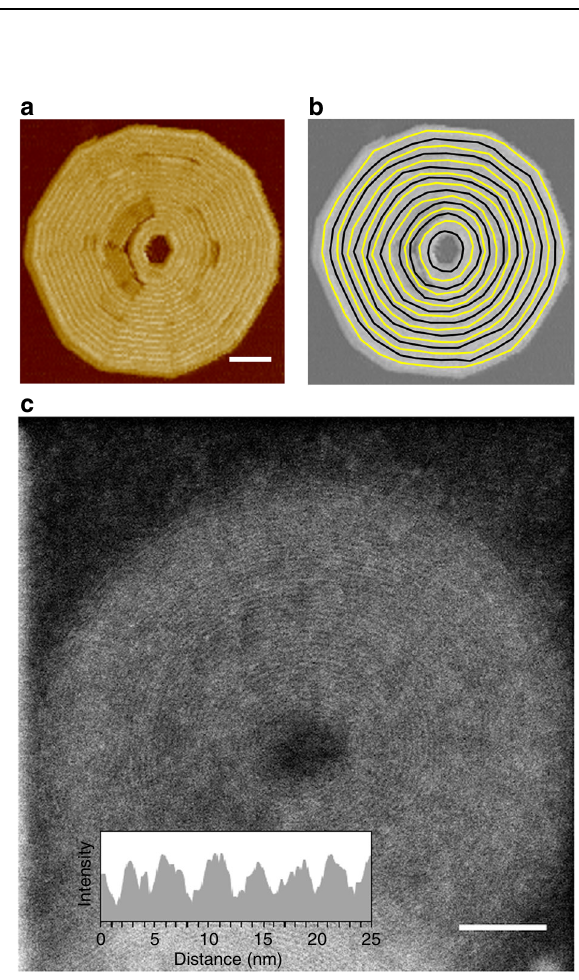
Fig. 5 Concentric toroids of 6FF. a , b AFM images and c ADF – STEM image of concentric toroids obtained by cooling a hot solution of 6FF (7.5 μ M) in dodecane. Scale bar = 50 nm ( a , c